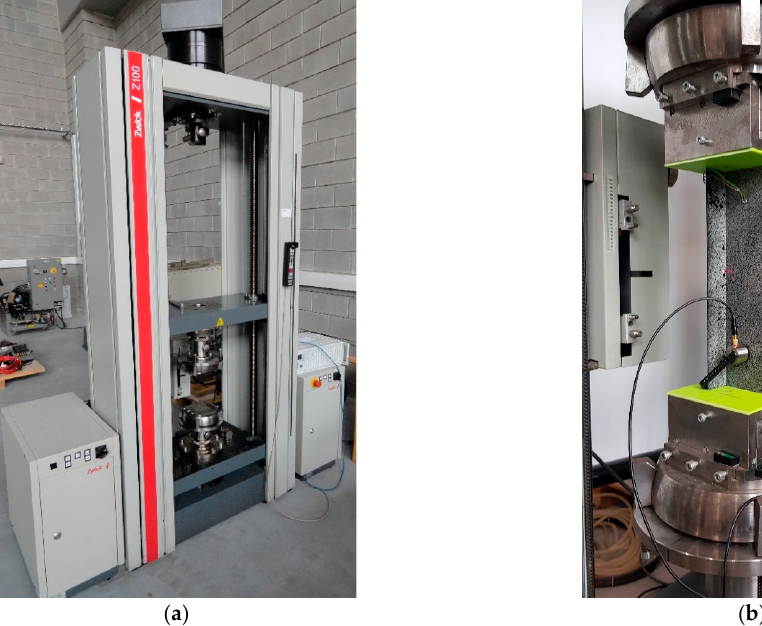
Figure 3. Experimental setup: ( a ) static testing machine and ( b ) test